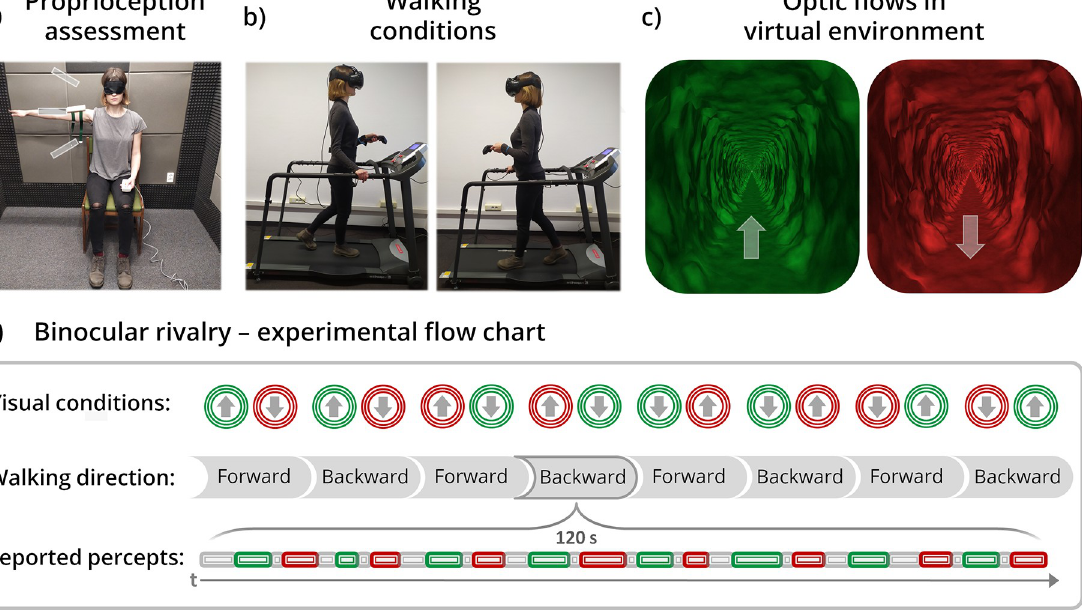
Fig 1. Experimental procedure. ( a ) Interindividual differences in active proprioception were assessed with a joint position reproduction task (the picture shows flexion at 90˚). ( b ) During the main task, participants walked either forwards or backwards on a treadmill while being presented with ( c ) different optic flow patterns (expanding and contracting) to each eye via the head-mounted display. Their task was to continuously report with a hand-held controller which of the coloured visualisations (red or green) was seen at each moment. ( d ) The experiment comprised eight blocks counterbalanced with respect to walking direction as well as the direction and colour of visualisations seen by each eye. (The brightness and contrast of the images have been adjusted for illustrative purposes; we obtained informed consent to publish the